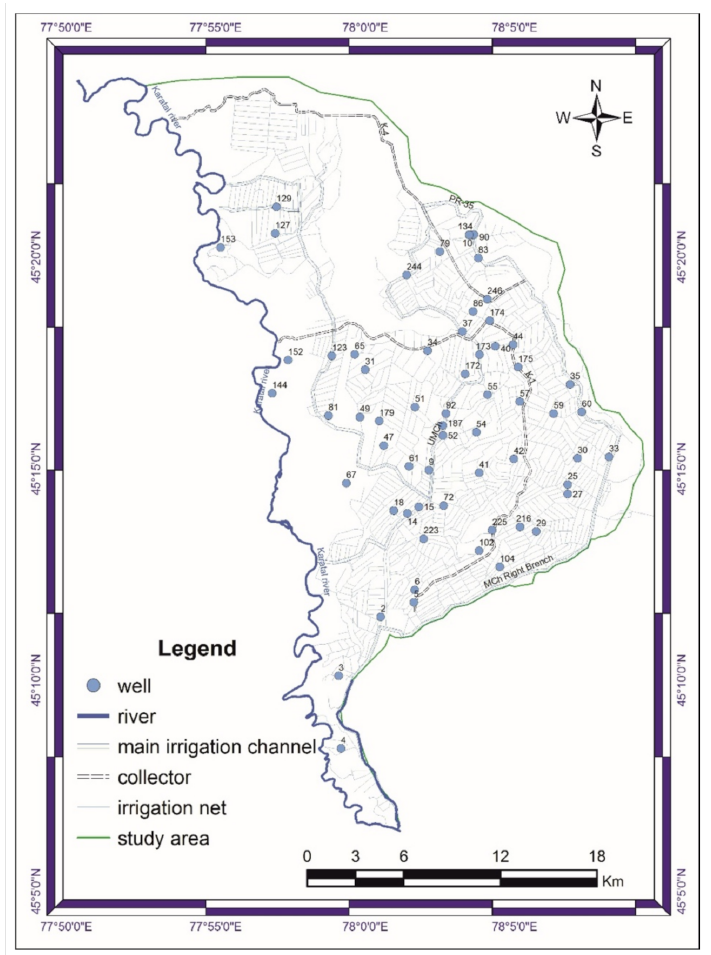
Figure 2. Scheme of the Karatal irrigation